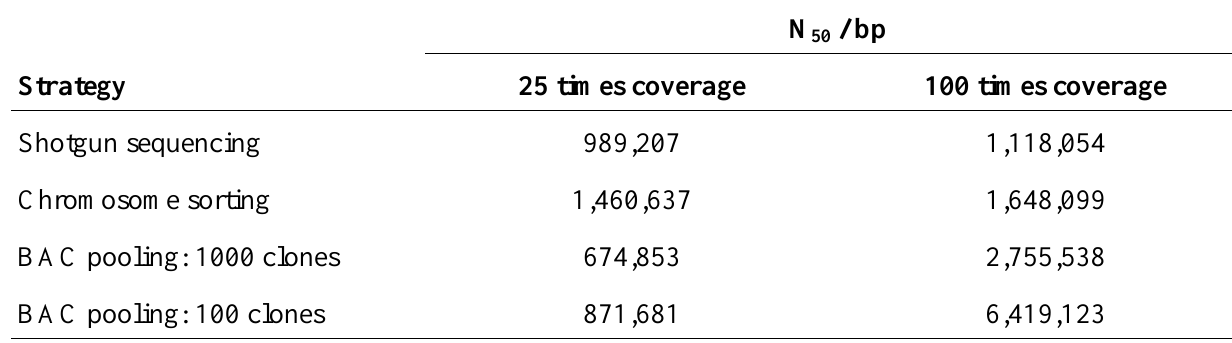
Table 1. Comparison of the assembly simulation results for four alternative sequencing strategies. Unpaired reads of length 400 bases were simulated and assembled against the full human genome as the reference. The simulations were performed with both 25- and 100-times overall coverage. The two BAC pools consisted of 1000 or 100 BAC clones. The BAC pools with 25-times overall depth were done with five-times BAC coverage of the genome and five-times read coverage of each clone. The pools with 100-times overall depth were done with 10-times BAC coverage and 10-times read